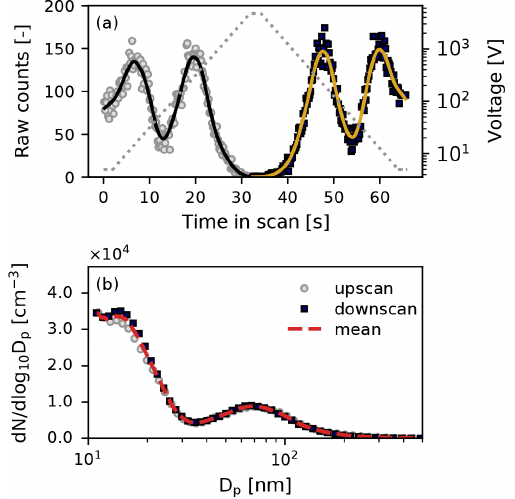
Figure 4. Example of Spider DMA data inversion. (a) Raw counts per time bin (symbols) recorded over the voltage ramp (up- and downscan). Solid lines indicate LOWESS smoothing to the raw counts. (b) Resulting size distributions after data inversion. The dashed line shows the mean of the up- and downscan